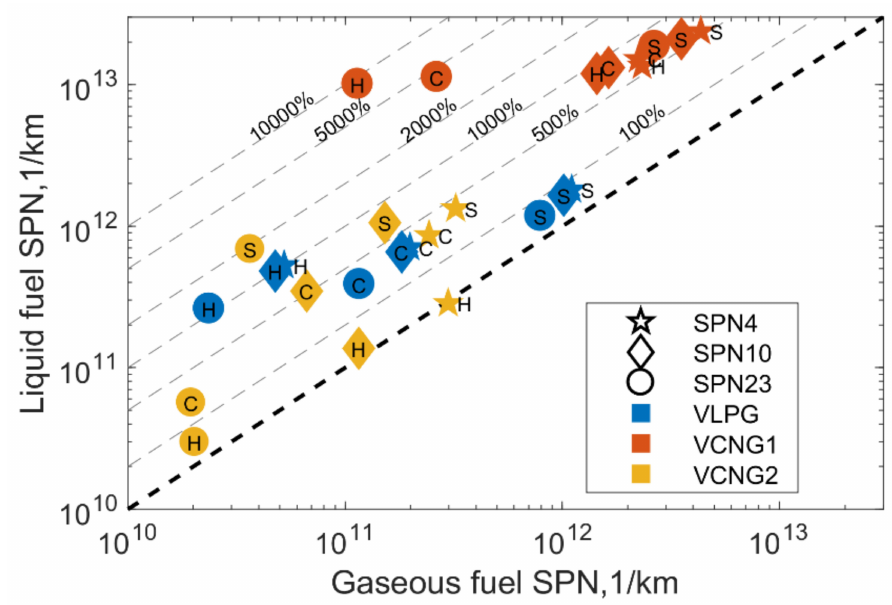
Figure 3. SPN measured in liquid fuel operation as a function of SPN measured in gaseous operation. Data labels in or next marker refer to 23 ◦ C hot start (H, circle) or cold start (C, diamond) or to sub-zero (S, star) tests. Blue markers are for LPG, red for VCNG1 and yellow for